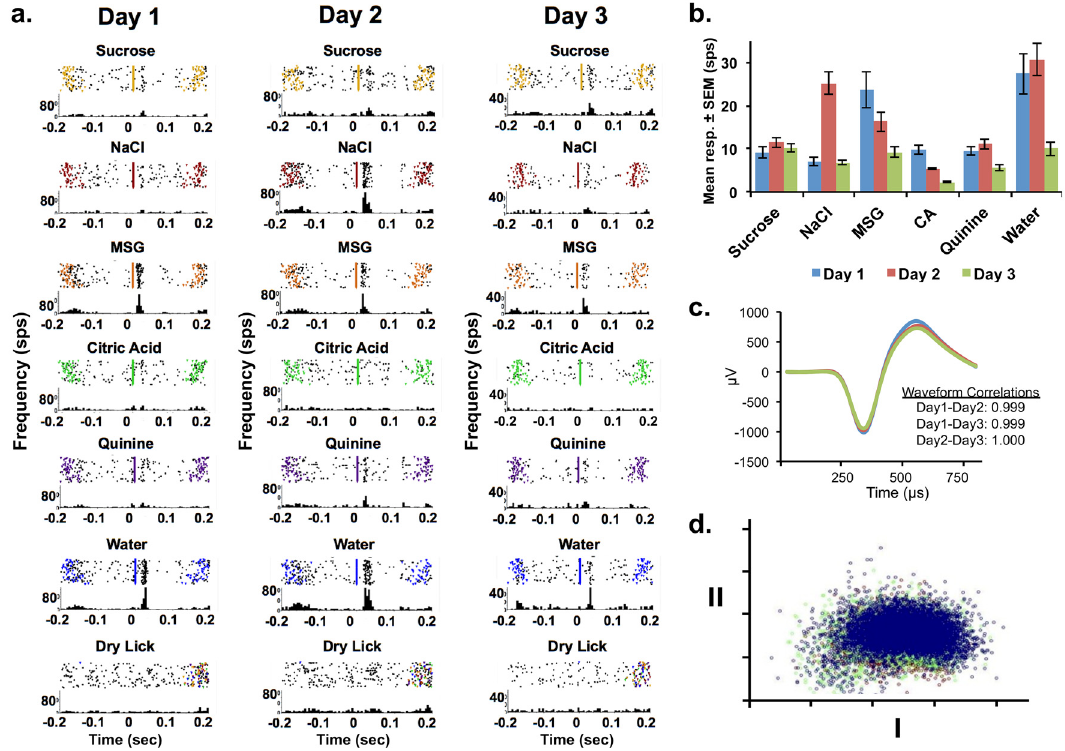
Fig 1. Example of a multiday recording of taste responses from a single PbN unit (#3 from Table 2). a) Rasters (top of each panel) and peristimulus-time histograms (bottom of each panel) evoked by each tastant across days. Colored triangles indicate the occurrence of a lick. b) Mean response magnitudes ± standard error of the mean (SEM) for each taste stimulus on each day. Abbreviation: CA, citric acid. This neuron showed a response to MSG that decreased across days, response to NaCl primarily on Day 2, a response to water that significantly decreased on the third day, and small responses to quinine and sucrose. c) Mean waveforms (800 μ s) recorded on the three days; inset: waveform correlation between days. d) Principal components analyses results for individual waveforms recorded on each of three days, color- coded by day.